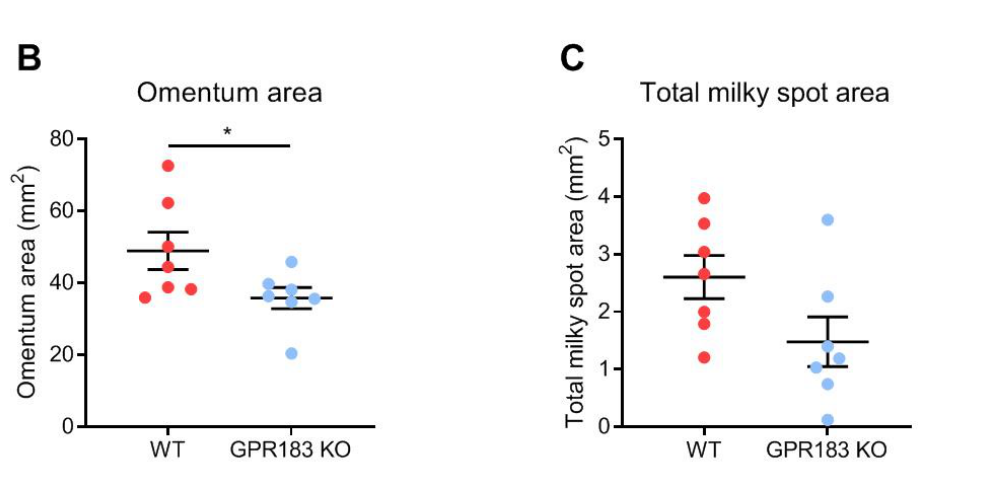
Figure 4. Omentum and milky spots in GPR183 KO mice; ( A ) whole omenta from WT ( left ) and GPR183 KO ( right ) mice stained with an anti-B220 antibody (red) and a Hoechst nuclear stain (blue) and imaged by fluorescence confocal microscopy. The insert shows a magnification of a single milky spot; ( B ) quantification of the total surface area of omenta from 7 10–14 weeks old WT and GPR183 KO mice; ( C ) quantification of the total area per omentum that constitutes milky spots, in the same omenta as in ( B ). The data were pooled from two independent experiments. Error bars represent mean ± SEM. * p < 0.05 by unpaired Student’s t